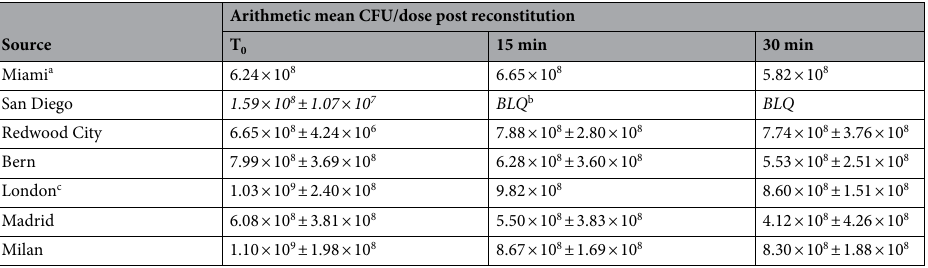
Table 1. PXVX0200 viability when reconstituted in US and EU tap waters (2018). Italicized values are below the PXVX0200 lower potency limit. a Miami sample was tested in singlicate due to availability of sample at the time of the study. b BLQ below level of quantification for the CFU assay. c 15 min time-point for London sample is derived from a single measurement as the duplicate had no growth, which was attributed to a missed dilution during CFU sample preparation.